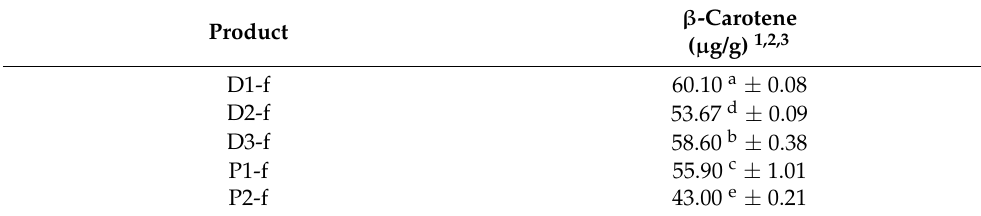
Table 4. β -carotene content for fruit extracts of Physalis peruviana